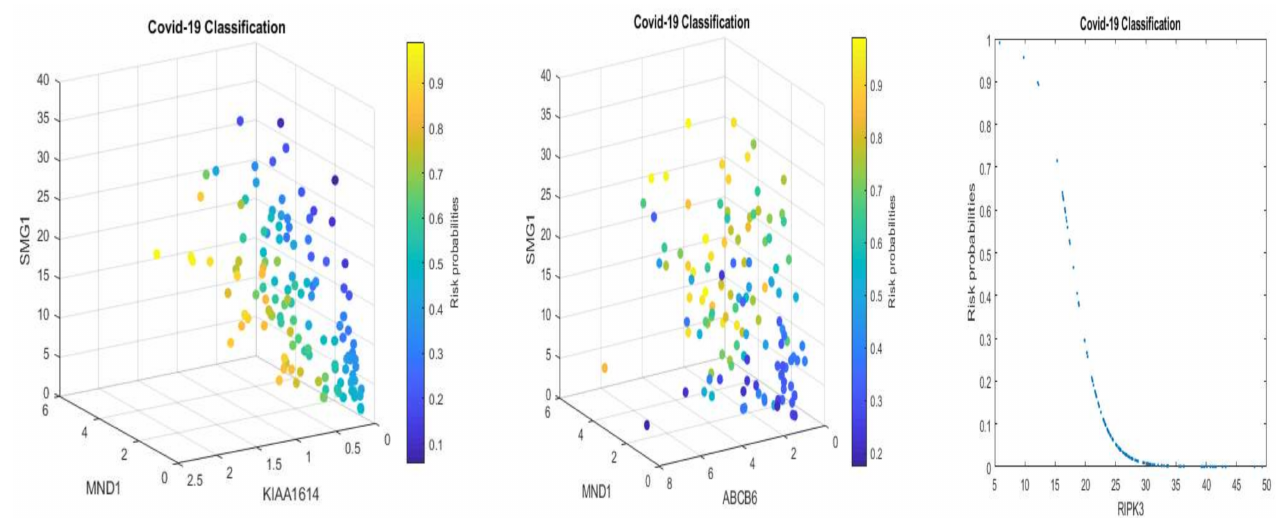
Figure 1. COVID-19 classifiers using TPM data with axis units corresponding to Table 2: visualization of gene-gene relationship and gene-risk probabilities. Note that 0.5 is the probability threshold. The left panel is for CF-I with the X-axis being MND1, Y-axis being KIAA1614, and Z-axis being SMG1. The risk probability bar is on the right. The middle panel is for CF-II with the X-axis being MND1, Y-axis being ABCB6, and Z-axis being SMG1. The risk probability bar is on the right. The right panel is for CF-III with the X-axis being RIPK3 and the Y-axis being the risk probability.